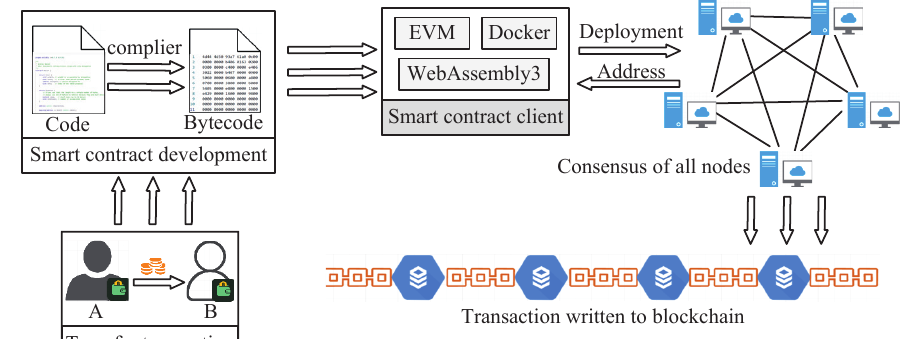
Figure 8. Smart contract